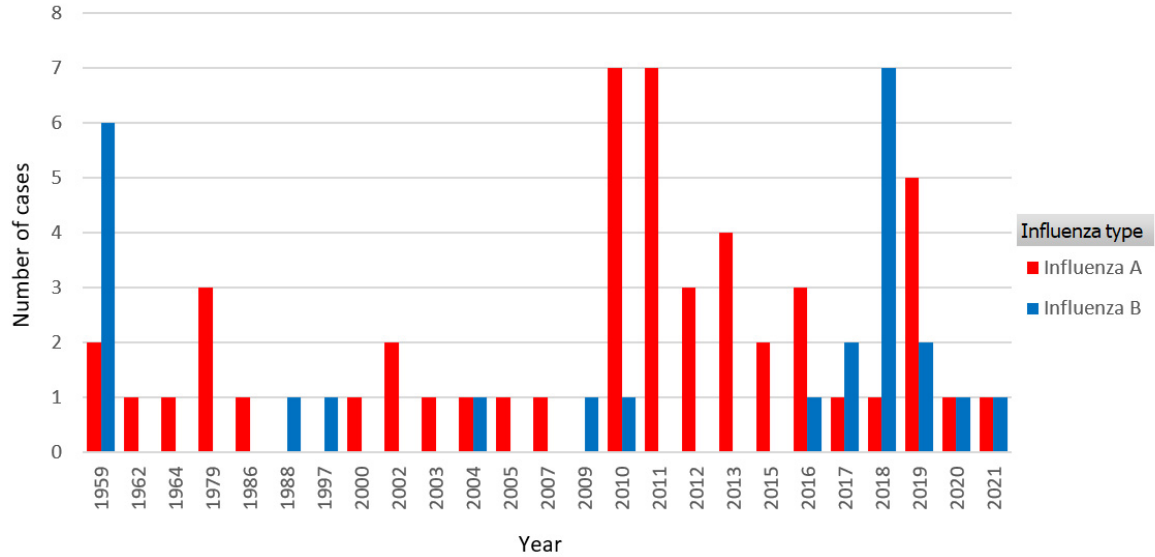
Figure 2. Influenza type distribution over years, with a notably higher incidence of reported cases during and after the 2009 influenza A (H1N1) pandemic.